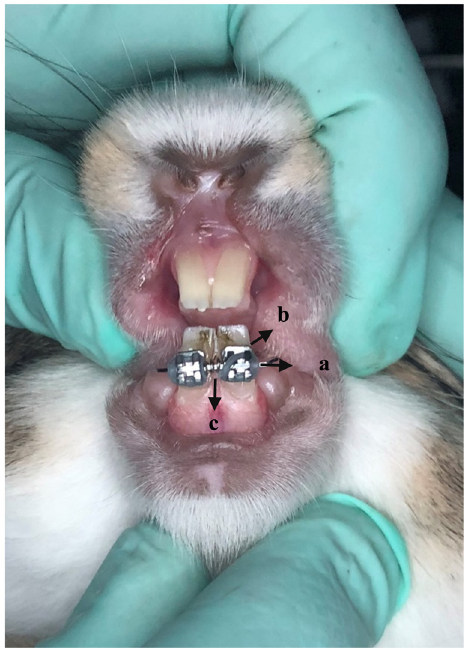
Figure 1. Design of the orthodontic device: ( a ) rectangular stainless steel wire, ( b ) preadjusted edgewise bracket, and ( c ) open coil spring. Figure 2. Gingival crevicular fluid